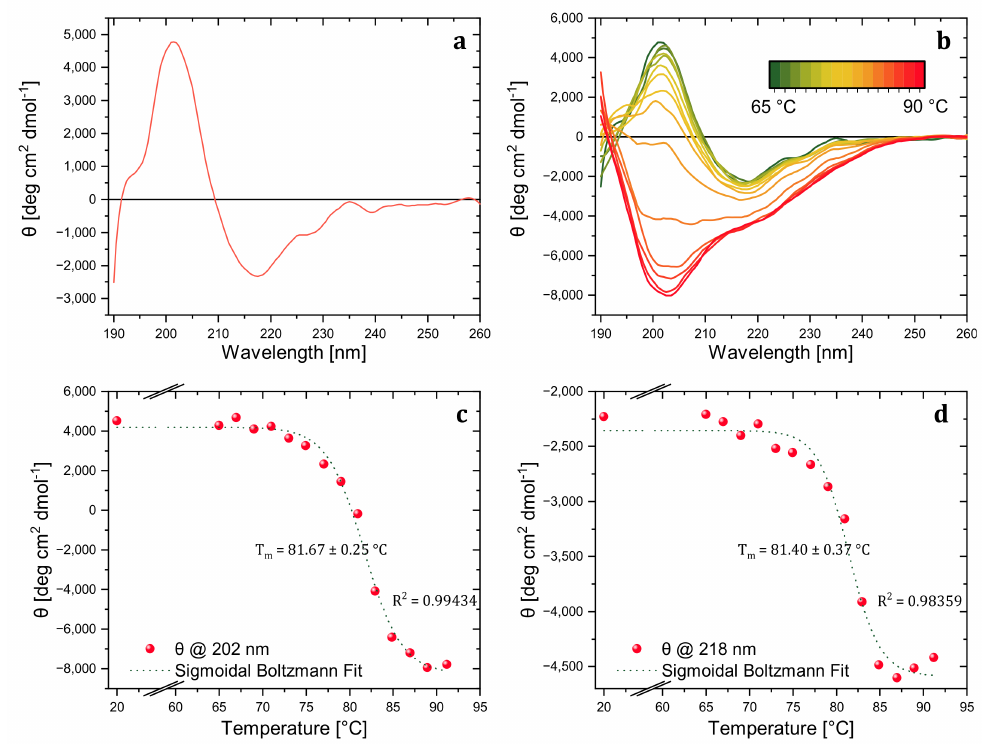
Figure 1. ( a ) The wavelength CD spectrum of 0.2 mg · mL − 1 trastuzumab at 20 ◦ C. ( b ) Temperature- wavelength CD spectrum of 0.2 mg · mL − 1 trastuzumab between 65–90 ◦ C by 2 ◦ C intervals at 218 nm ( c ) Denaturation curve of trastuzumab at 202 nm. ( d ) Denaturation curve of trastuzumab at 218